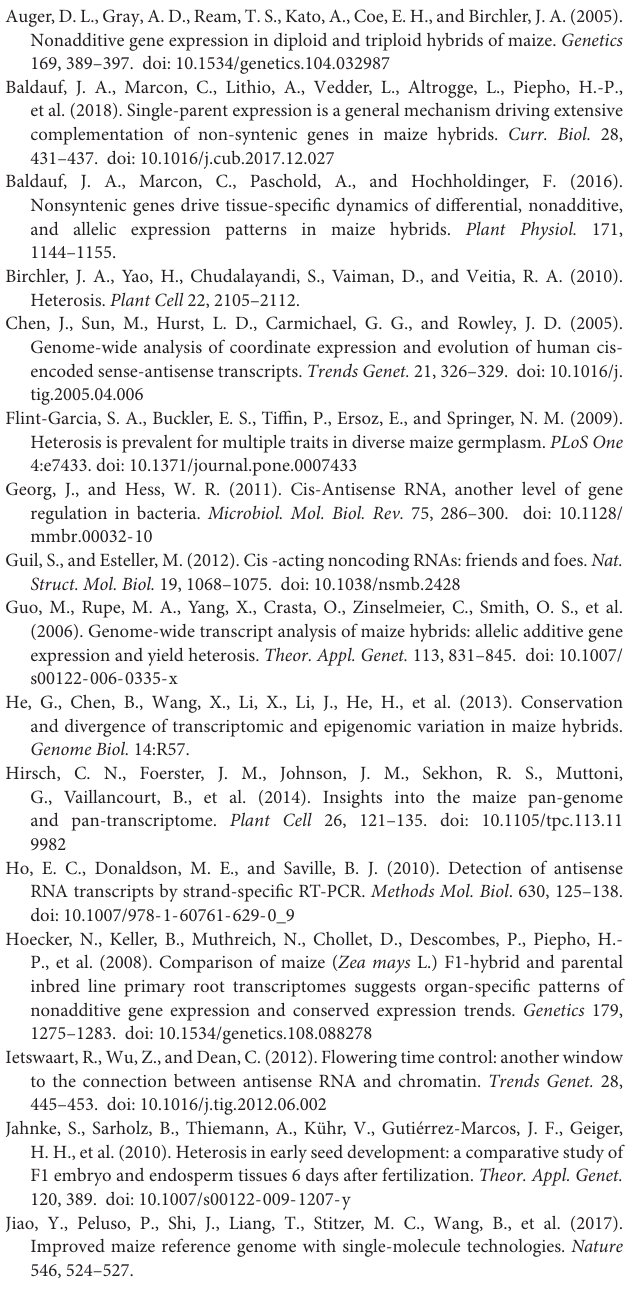
and sense transcript (B73/Mo17) was plotted. The r 2 (PCC) was calculated by the fold change value of anti-sense and sense transcript. Supplementary Figure 5 | qPCR validation of sense and anti-sense transcripts using four genes. Supplementary Table 1 | Summary of sequencing data. Supplementary Table 2 | SPEA list identified in immature ear and leave tissues. Supplementary Table 3 | Primer used for experimental